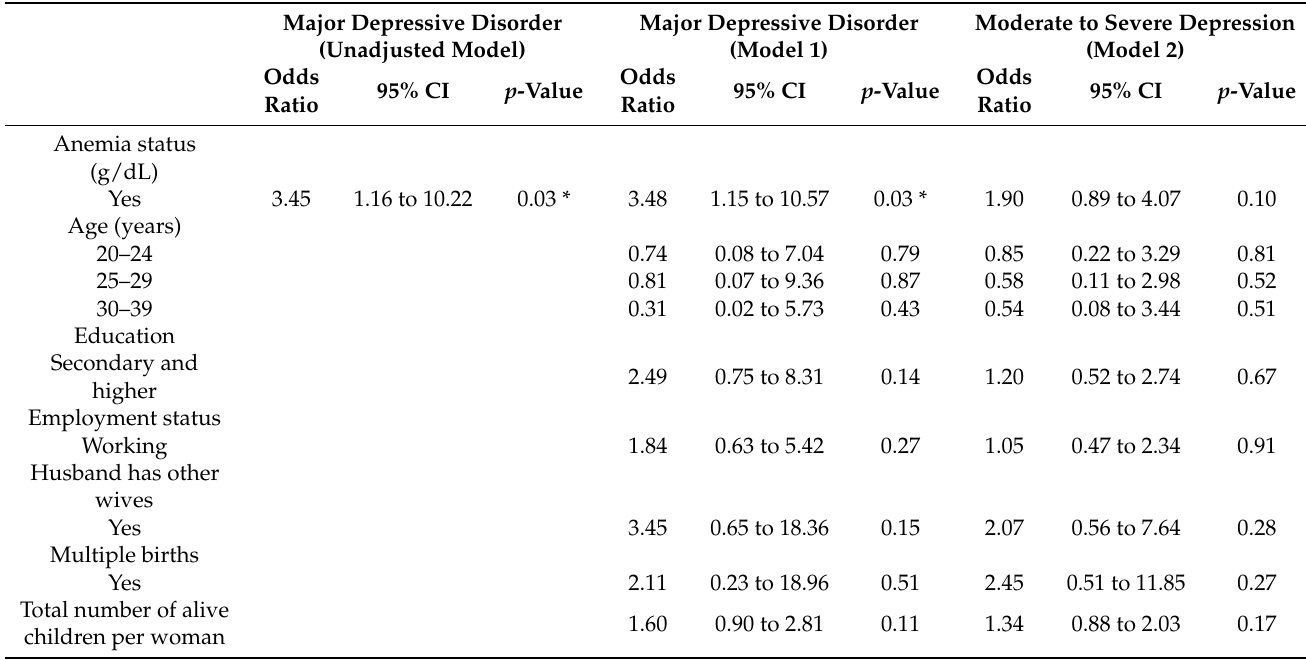
Table 3. Regression: Odds ratios, p -values, and 95% confidence intervals (CI) for correlates of major depressive disorder and moderate to severe depression (a cutoff score of 10 on the PHQ-9 questionnaire), using anemia as a binary